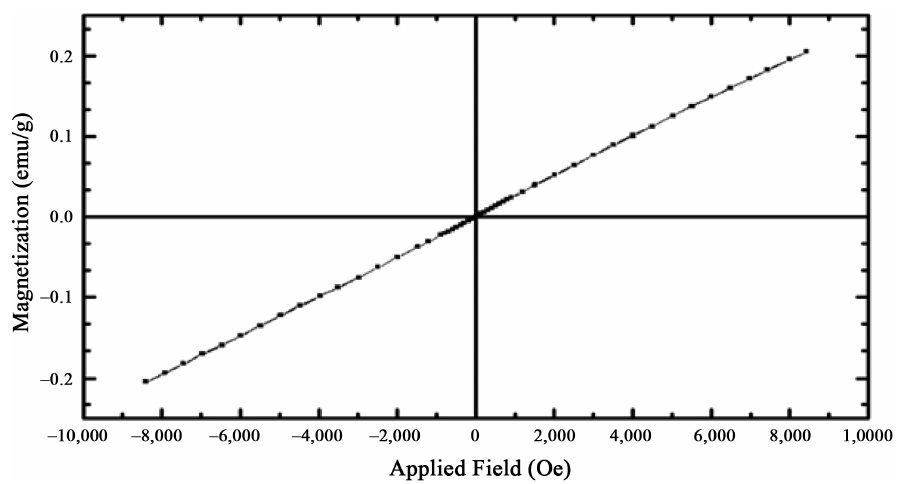
Figure 4: VSM curve of the NiCr 2 O 4